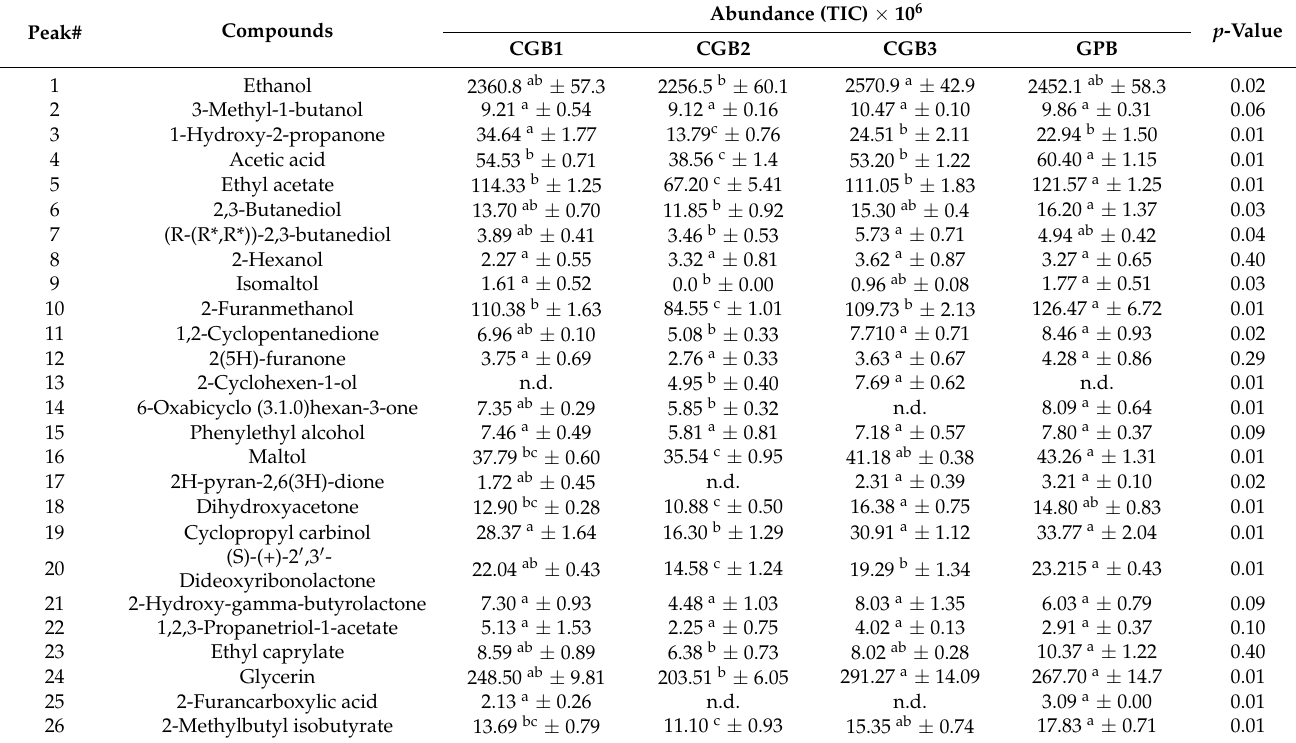
Table 3. Volatile compounds identified in